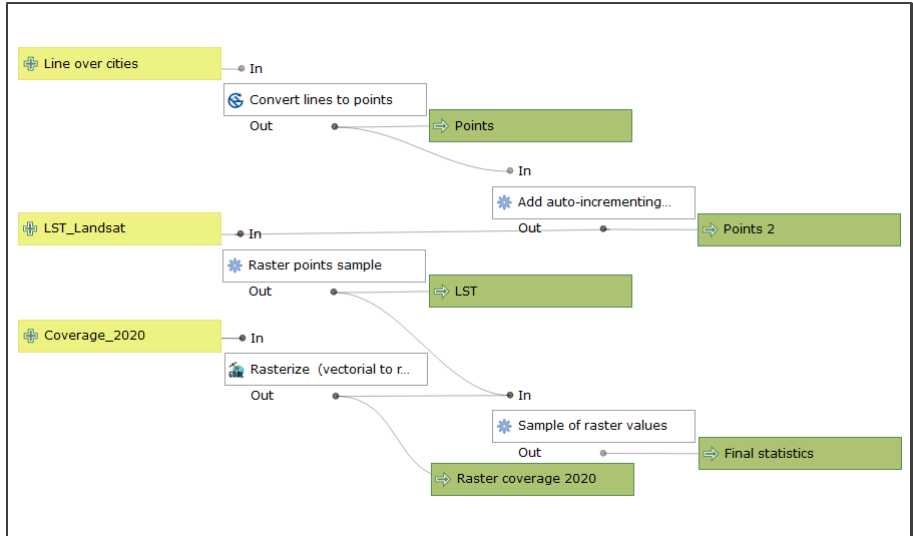
Figure 4. QGIS Modeler Processing to Obtain LST Values, Land Cover, and Current Land Uses of Transects.